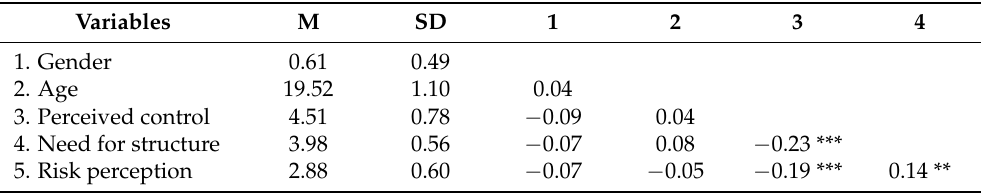
Table 1. Study 1 descriptive statistics and correlations ( N =